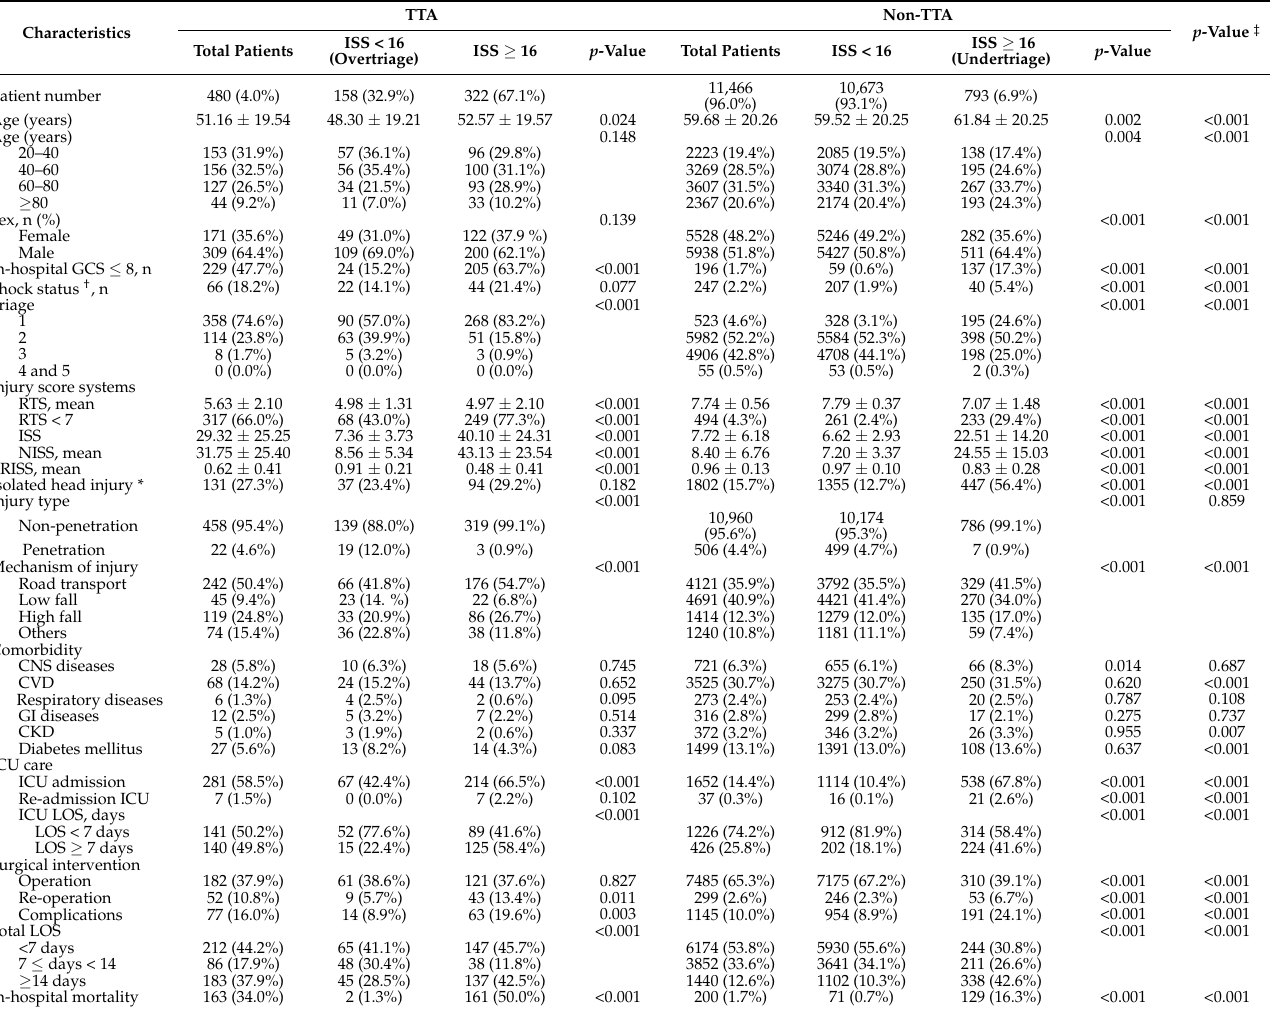
Table 2. Comparison of demographic characteristics of patients in the TTA group and the non-TTA group with minor and major